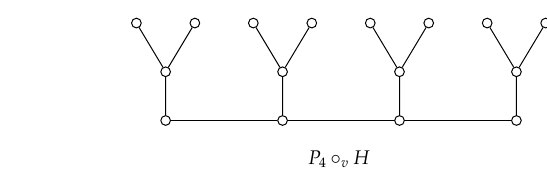
Figure 1. The rooted product graph P 4 ◦ v H